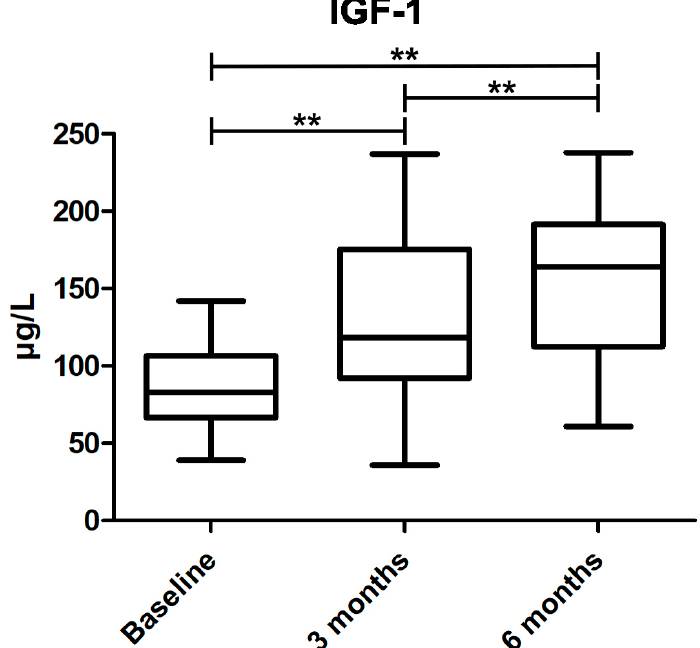
Figure 1. Insulin-like growth factor 1 (IGF-1) levels over time. Box plots with interquartile range of IGF-1 levels at baseline and 3 and 6 months follow up. ** indicates significance p < 0.01. Statistical analysis, with Wilcoxon matched-pairs signed rank test, showed an increase of copeptin levels during the treatment period between baseline and 3 months and baseline and 6 months ( p < 0.01 for both periods) but no further increase between 3 and 6 months ( p = 0.91), see Figure